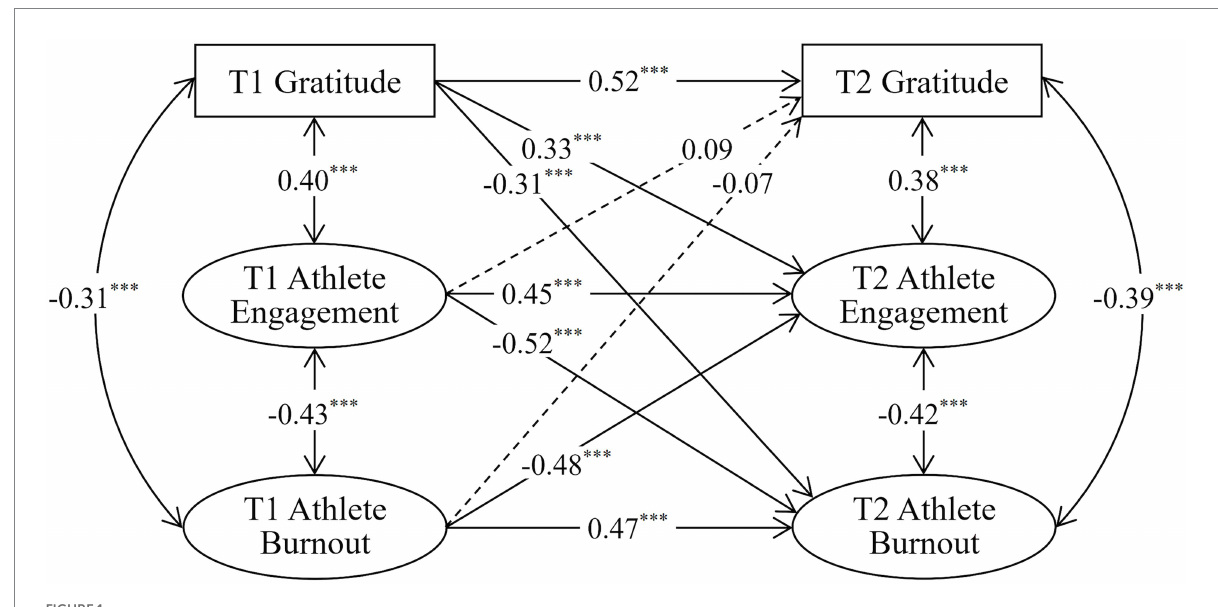
FIGURE 1 Cross-lagged model of athlete gratitude, athlete engagement and athlete burnout. *** p < 0.001. The values in the figure are standardized path